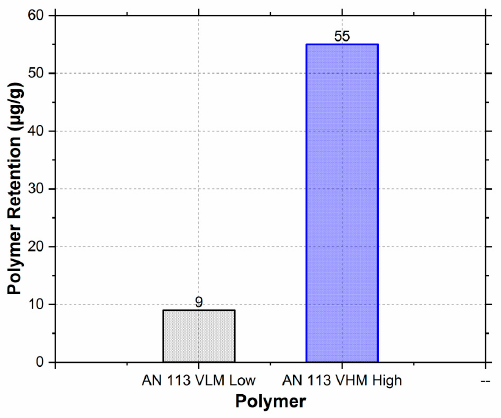
Figure 3. Retention behavior at 1000 ppm of polymer with 5000 ppm NaCl salinity.